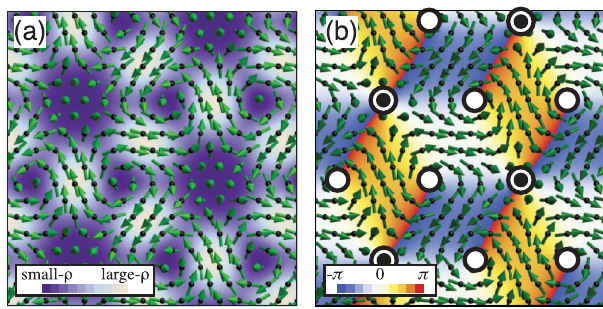
FIG. 8 The 6- Q II BEC state for κ ¼ þ 1 , Θ ¼ 0 , and j Q showing (a) the boson density and (b) boson phase distributions. The open (filled double) circles indicate vortices (double-anti-